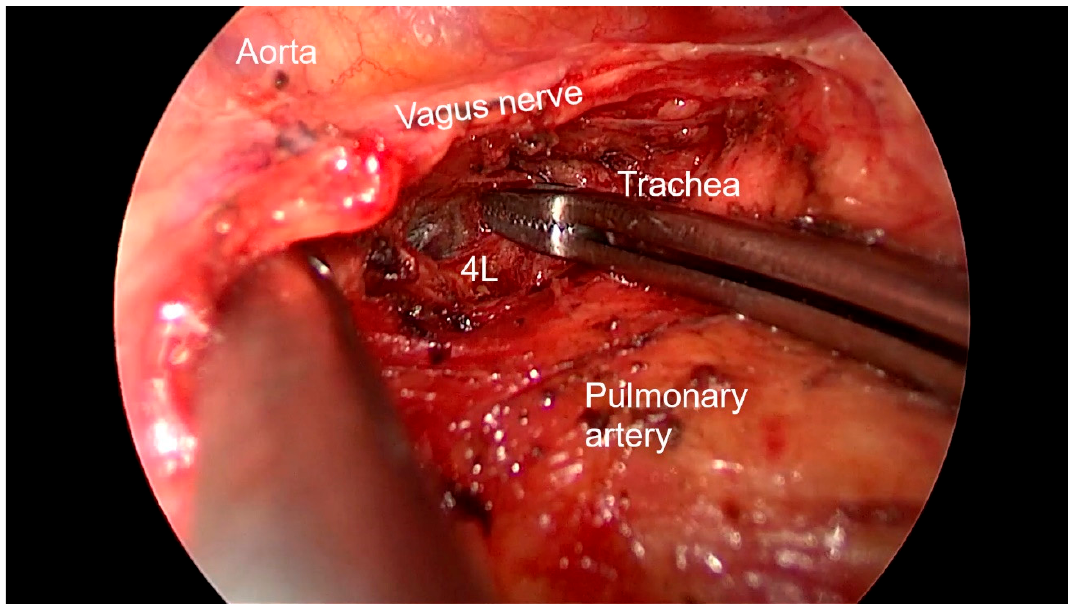
Figure 9. Anatomic landmarks during left paratracheal lymph node dissection (4L).